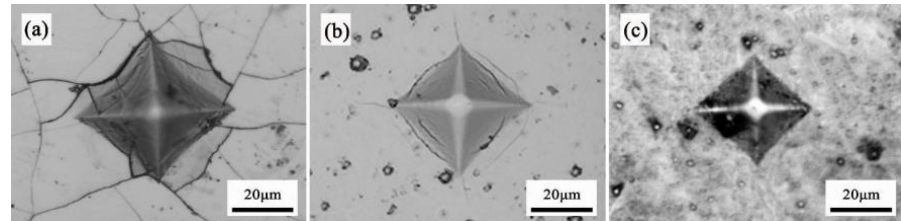
Figure 6. Microhardness morphology of chromium coatings (working load 100 g, holding load 10 s) ( a ) EPHC; ( b ) MSIP; ( c ) MAIP.